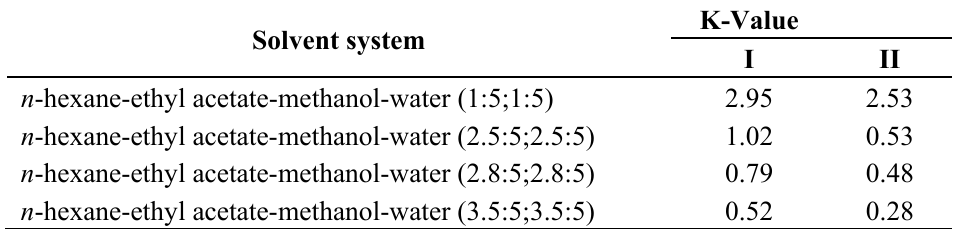
Table 1. The K-values of the compounds in different two-phase